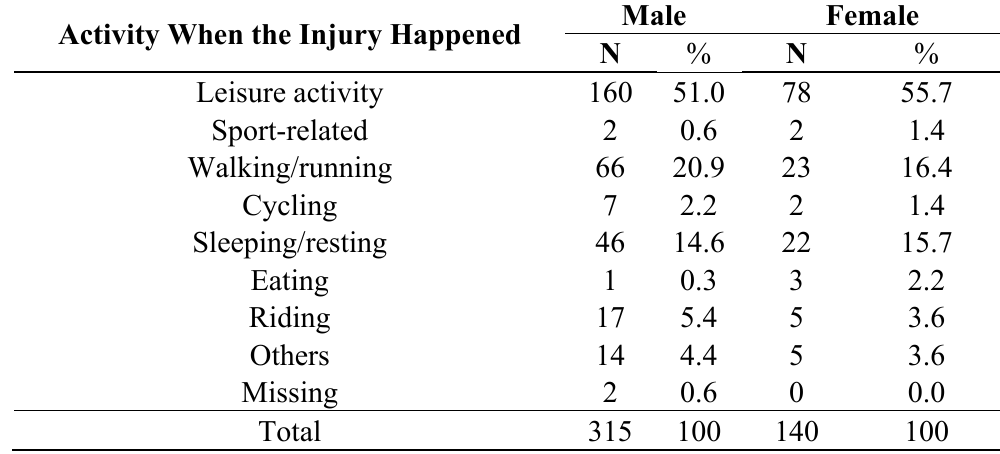
Table 2. Distribution of activity when the injury happened in children with MTBI by